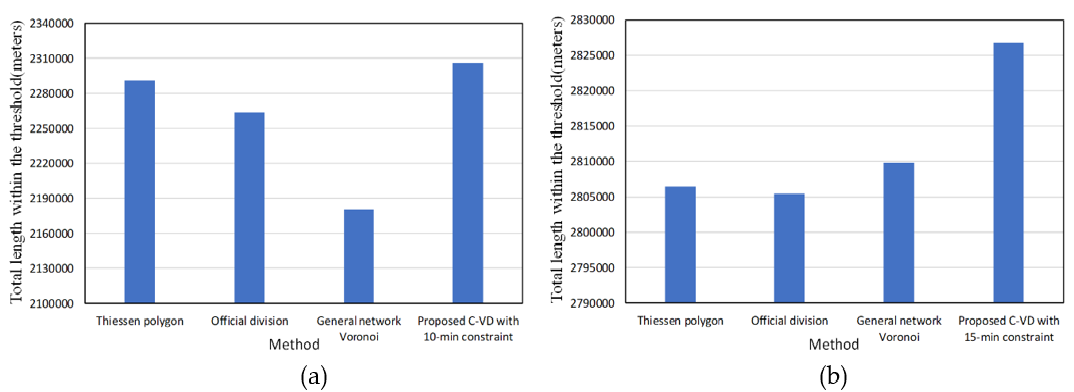
Figure 18. The street segment length of service areas within the 10-min threshold ( a ) and the 15-min threshold ( b ) obtained by different methods.